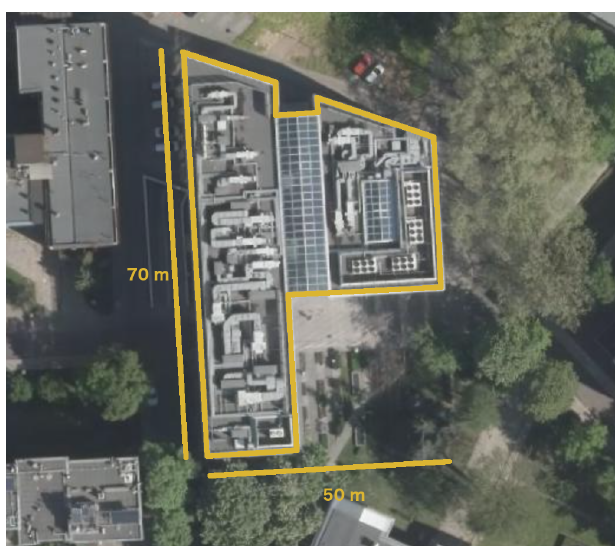
Figure 1. Faculty of Mathematics and Information Science (MIS) of Warsaw University of